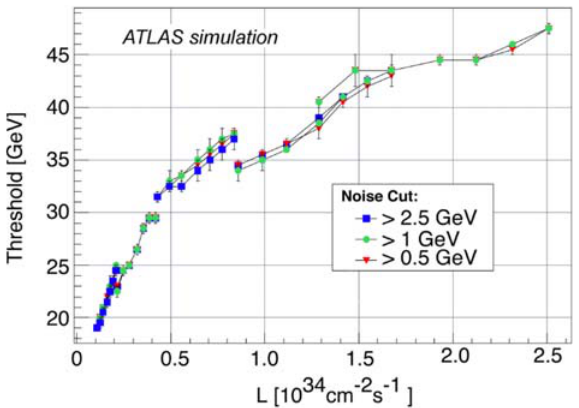
Figure 1. Predicted E T threshold at Level-1 for non-isolated EM clusters as a function of instantaneous luminosity that will yield a 20 kHz Level-1 trigger